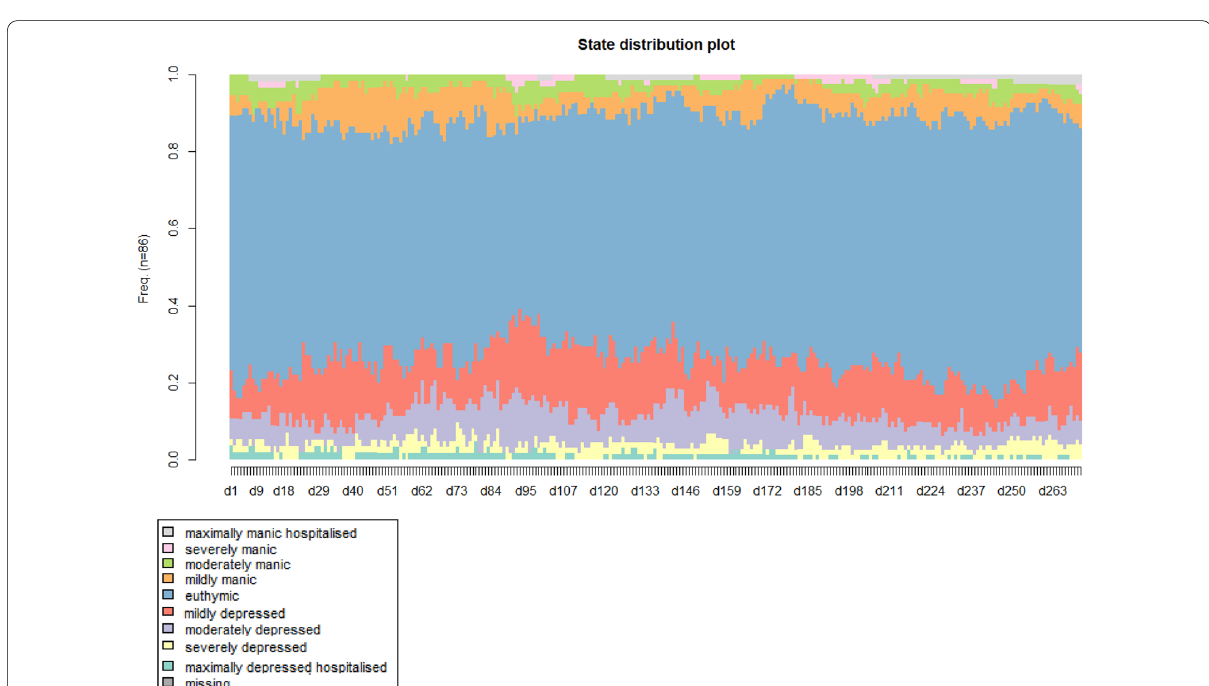
Fig. 1 Index plot: distribution of states (daily self rated severity score) for both samples (pregnant and non‑pregnant women, n observation period of 272 days. X‑axis: time in days, Y axis: proportions women distributed over states described in the